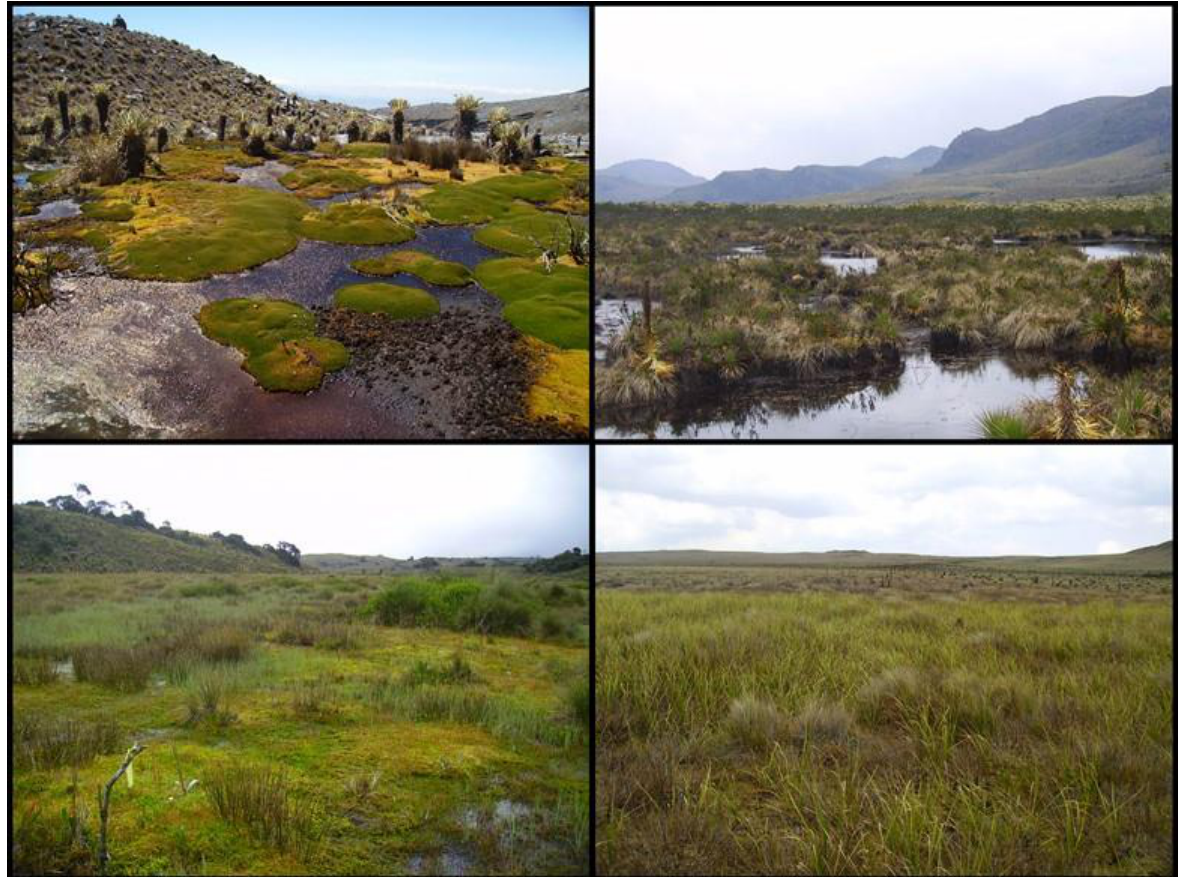
Figure 3. The main peat-forming vegetation types in the northern Andes. ( Top left ): cushion-plant- dominated with Distichia muscoides and Campylopus ; ( top right ): a sedge-dominated site; ( bottom left ): site dominated by Sphagnum sancto-josephense ; ( bottom right ): a peatland dominated by true mosses and Calamagrostis effussa .